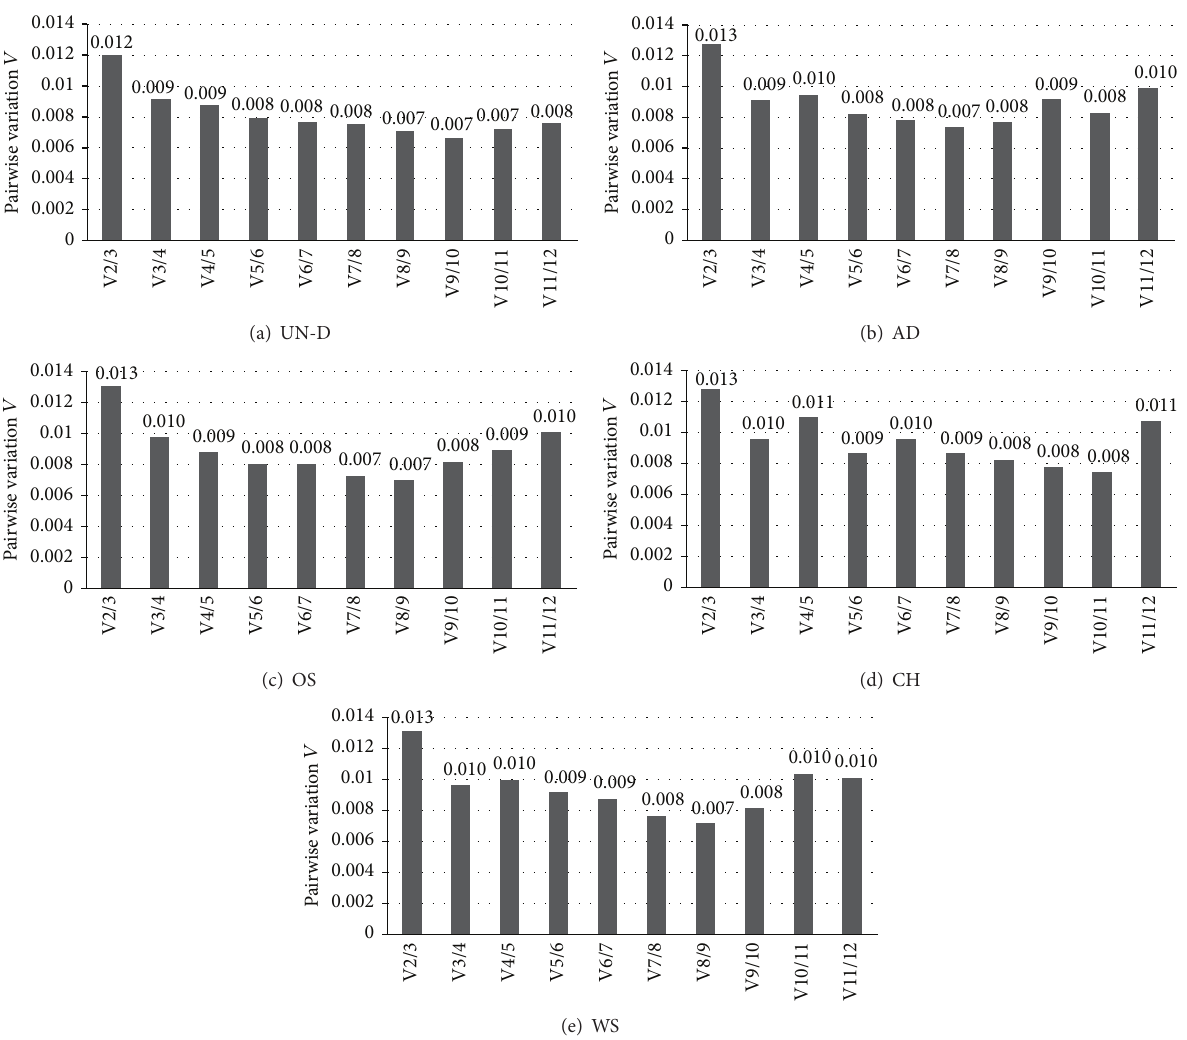
Figure 6: Optimal number of reference genes for normalization. Determining optimal number of reference genes is based on pairwise variation 𝑉 𝑛/𝑛+1 by calculating each two sequential normalization factors. The low V value indicates optimal number of reference genes normalized to target genes. Each V value is presented above bars. V values for (a) undifferentiated status of BMSCs, AMSCs, and SMSCs and (b–d) differentiated cells into adipocytes, osteocytes, and chondrocytes, respectively. (e) Whole status of